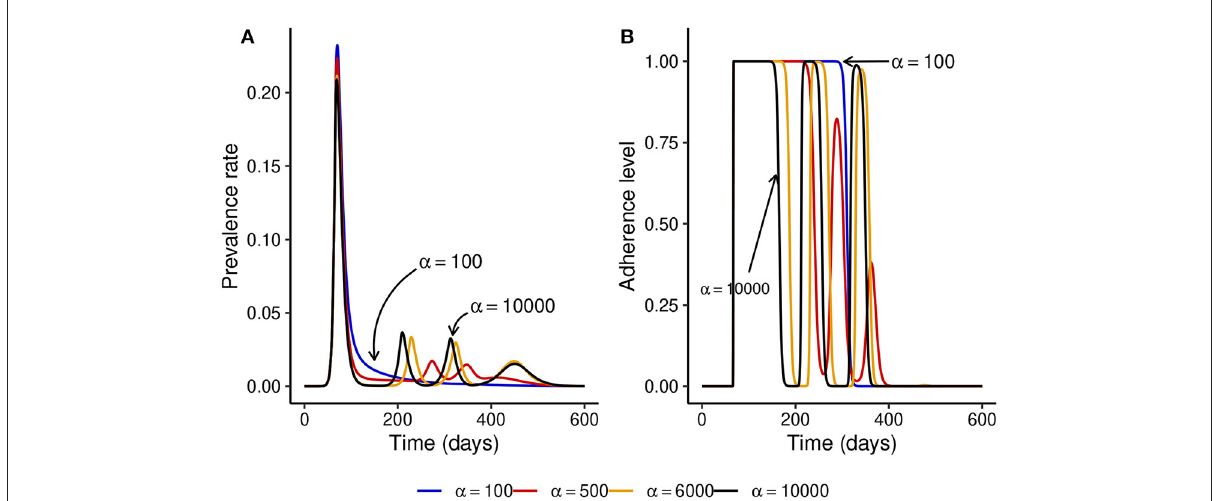
FIGURE3 Effect of increasing the stringency of NPIs, α , when the level of adherence to NPIs is time-varying and ω = 100 is fixed. This shows that if the public tolerance for the disease is not sufficiently low, increasing NPI stringency results only in a marginal decrease in the peak prevalence and can induce the occurrence of multiple epidemic waves. This is in contrast with what is observed in Figure 1 when the NPI adherence level is constant over time. (A) The prevalence rate of the disease. (B) Time-varying adherence level to NPIs.